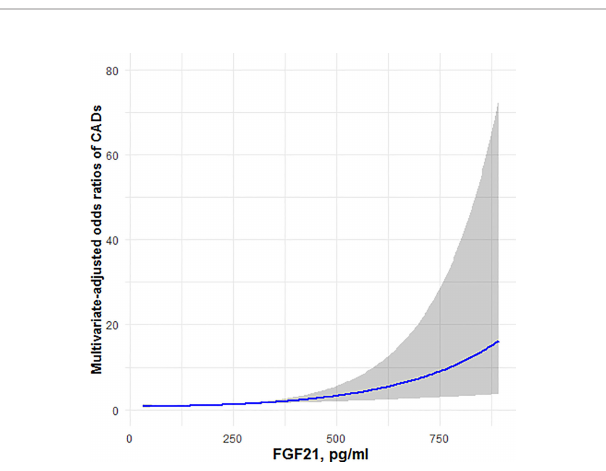
FIGURE 1 | Restricted cubic spline model of the odds ratios of CAD with circulating FGF21. The gray areas represent the 95% con fi dence intervals.